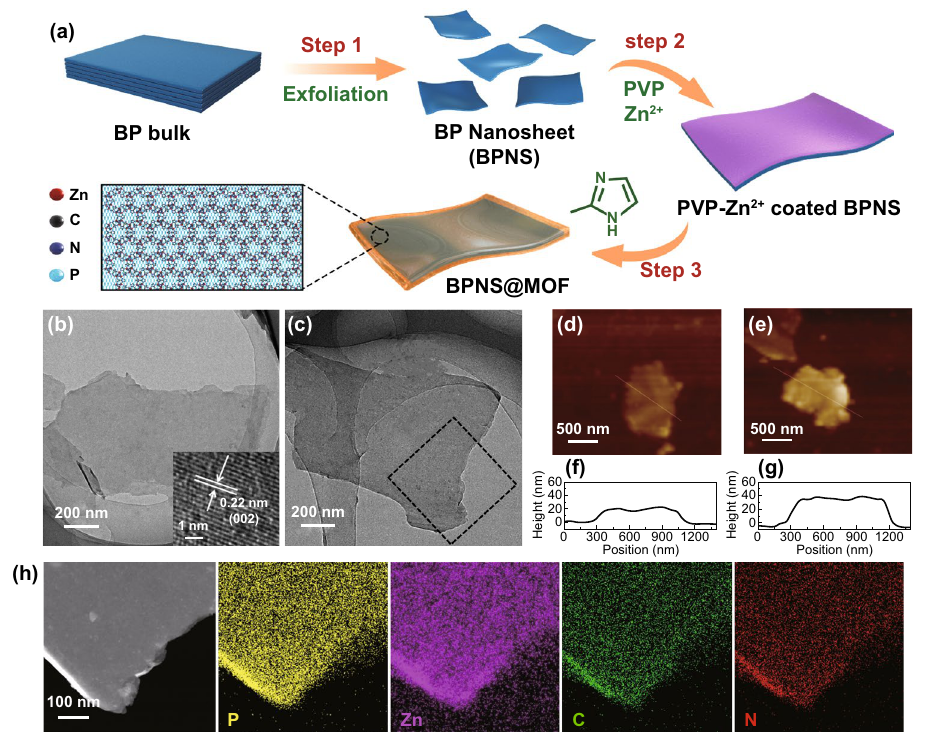
Fig. 1 a Schematic illustration of the formation process of the BPNS@MOF. b, c TEM images of the pristine BPNSs ( b ) and BPNS@MOF ( c ). The inset in ( b ) is a HRTEM image showing crystal lattices for the BPNSs. The black dotted box in ( c ) corresponds to the area of element mappings in ( h ). d, e AFM images of BPNSs ( d ) and BPNS@MOF ( e ). f, g Height profiles along the white lines in ( d ) and ( e ). h Scanning TEM image and the corresponding element mappings of P, Zn, C and N elements of the